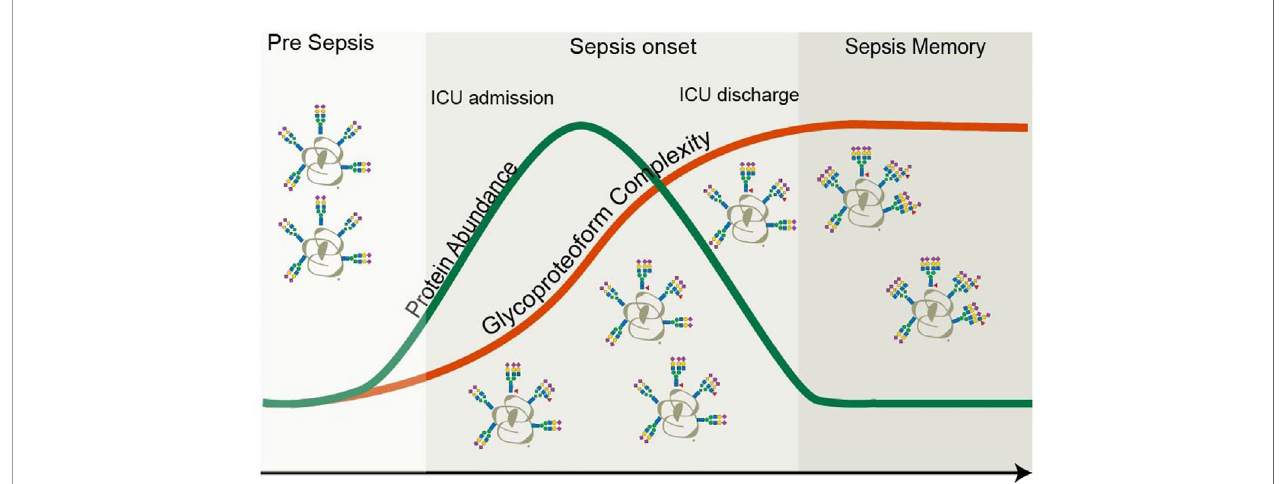
FIGURE 7 | Protein versus proteoform pro fi ling. In this study, both the protein abundance as well as proteoform pro fi le of the plasma protein AACT were monitored longitudinally in ten patients that experienced a septic episode. As AACT is a positive acute-phase protein, its concentration increased during the septic episode and returned to baseline, following the same trend in time as the clinically used marker CRP. Upon return to baseline of CRP (and thus also AACT), patients are typically released from the intensive care unit. At the start of the septic episode also the glycoproteoform pro fi le of AACT started to change and become remodeled and more complicated by the accumulation of additional branches, LacNAc elongations, and additional fucose moieties. Glycosylation remodeling proceeds even after the protein levels have gone back to “ normal, ” and patients are released from the ICU. This fi nding means that a memory effect of the septic episode is still present in the patients ’ AACT days to weeks after the release from the